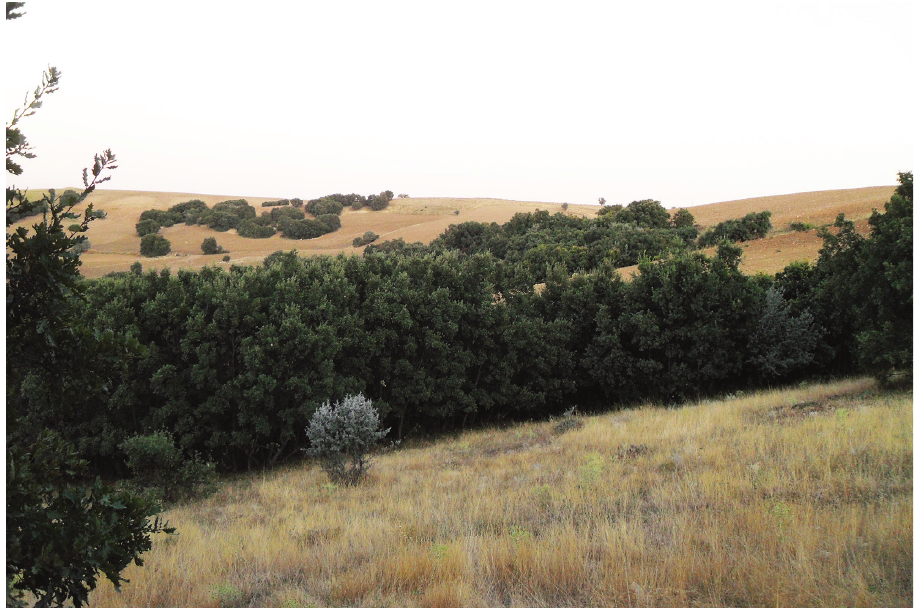
Figure 43. Type locality of Lathys ankaraensis sp.